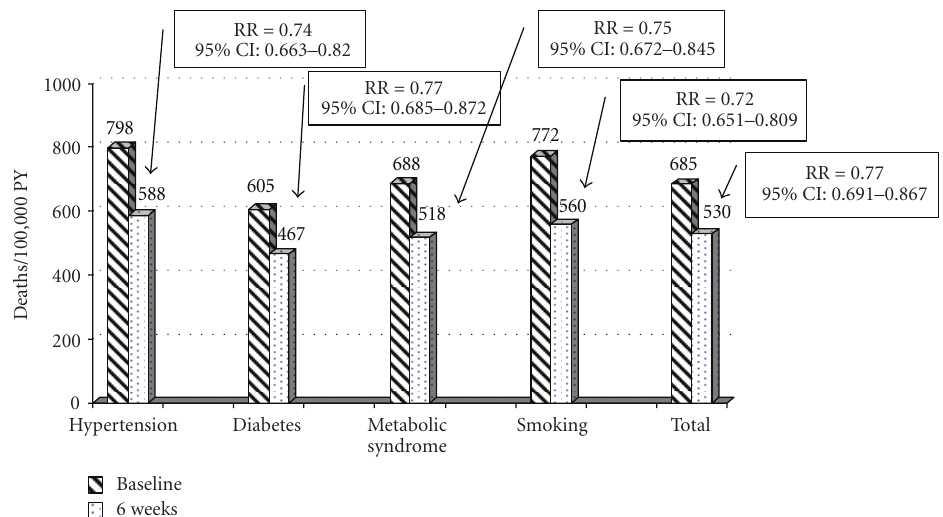
Figure 2: CVD Mortality (Estimated Deaths/100,000 PY). PY =